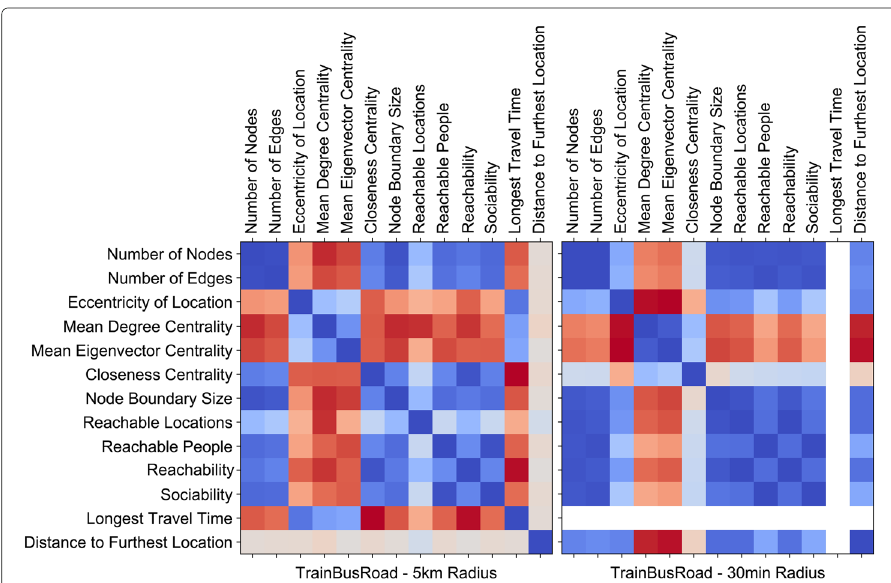
Fig. 7 Correlation matrices of the core measures on the fully integrated travel pattern within 5 km (left) and 30 min (right) across locations. Figures for other travel patterns appear in the Additional file 1. For each travel pattern the correlation pattern is consistent across time threshold, so only the 30 min matrix is shown